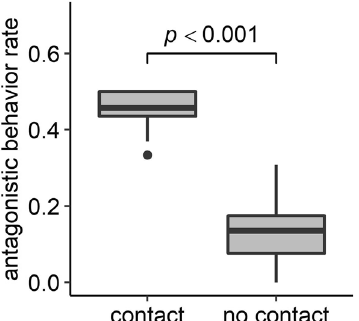
Figure 2. Rates of antagonistic behaviors of “contact” ants (ants attending aphids) and “no-contact” ants (ants climbing the stem from the ground to an aphid colony). The rates were significantly different between the contact group and the no-contact group (GLMM: estimate = − 1.608, n = 80, z = − 18.165, p < 0.001). The boxplots show the median, upper and lower quartiles, minimum and maximum, and any outliers.